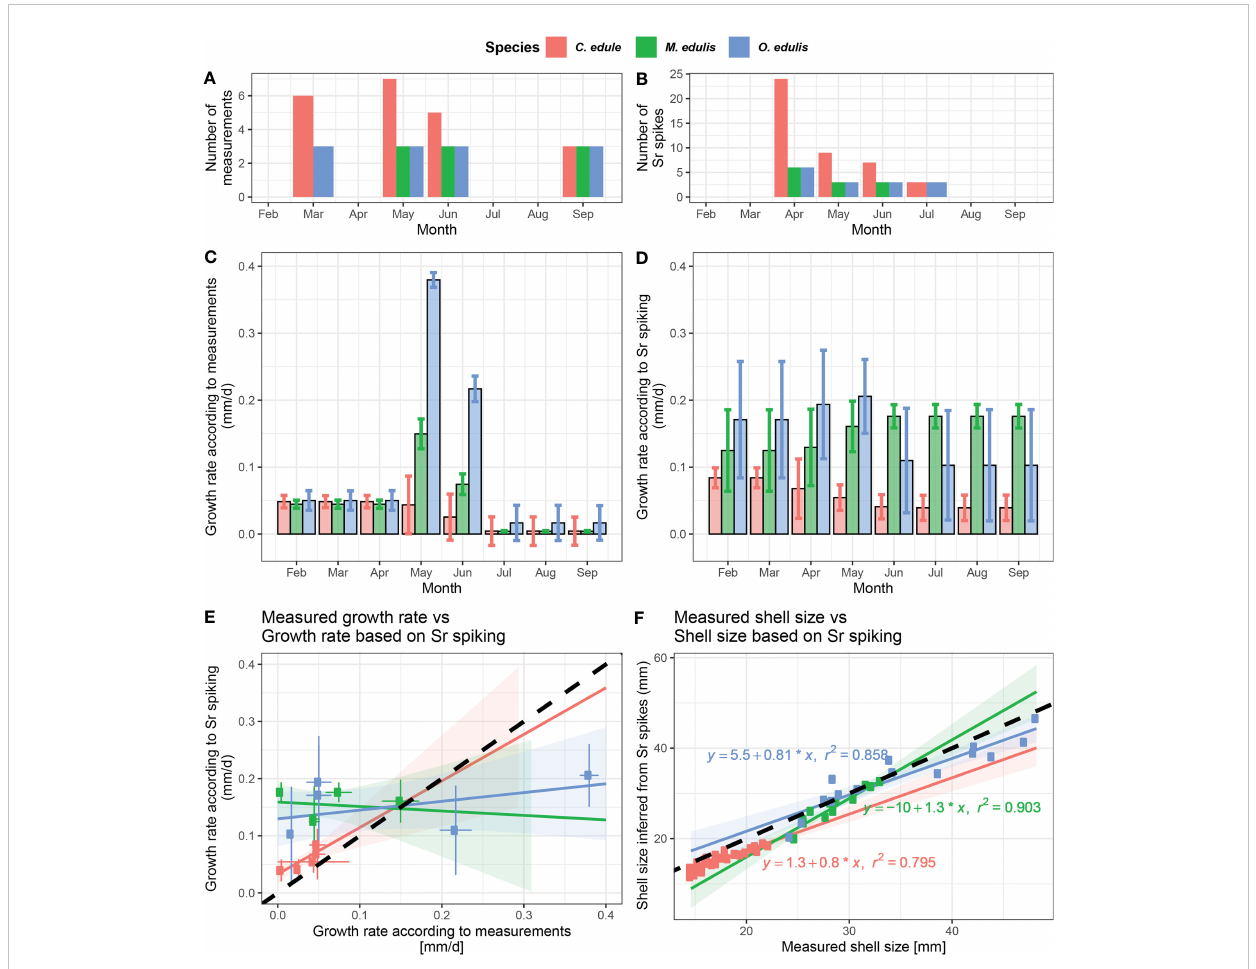
FIGURE 8 Comparison between shell sizes and growth rates calculated based on Sr spikes and shell length measurements. (A) Number of shell size measurements per month per species. (B) Number of Sr spikes per month per species. (C) Mean monthly growth rates calculated from shell size measurements per species. (D) Mean monthly growth rates calculated from positions of Sr spikes per species. (E) Cross plot showing growth rates calculated from shell size measurements against growth rates for the same month and the same species as calculated from the position of Sr peaks. The bold dashed line indicates equal growth rates between the two methods. (F) Cross plots showing measured shell size against shell size at the same time as determined from the position of Sr peaks. The bold dashed line indicates equal shell size estimates between the two